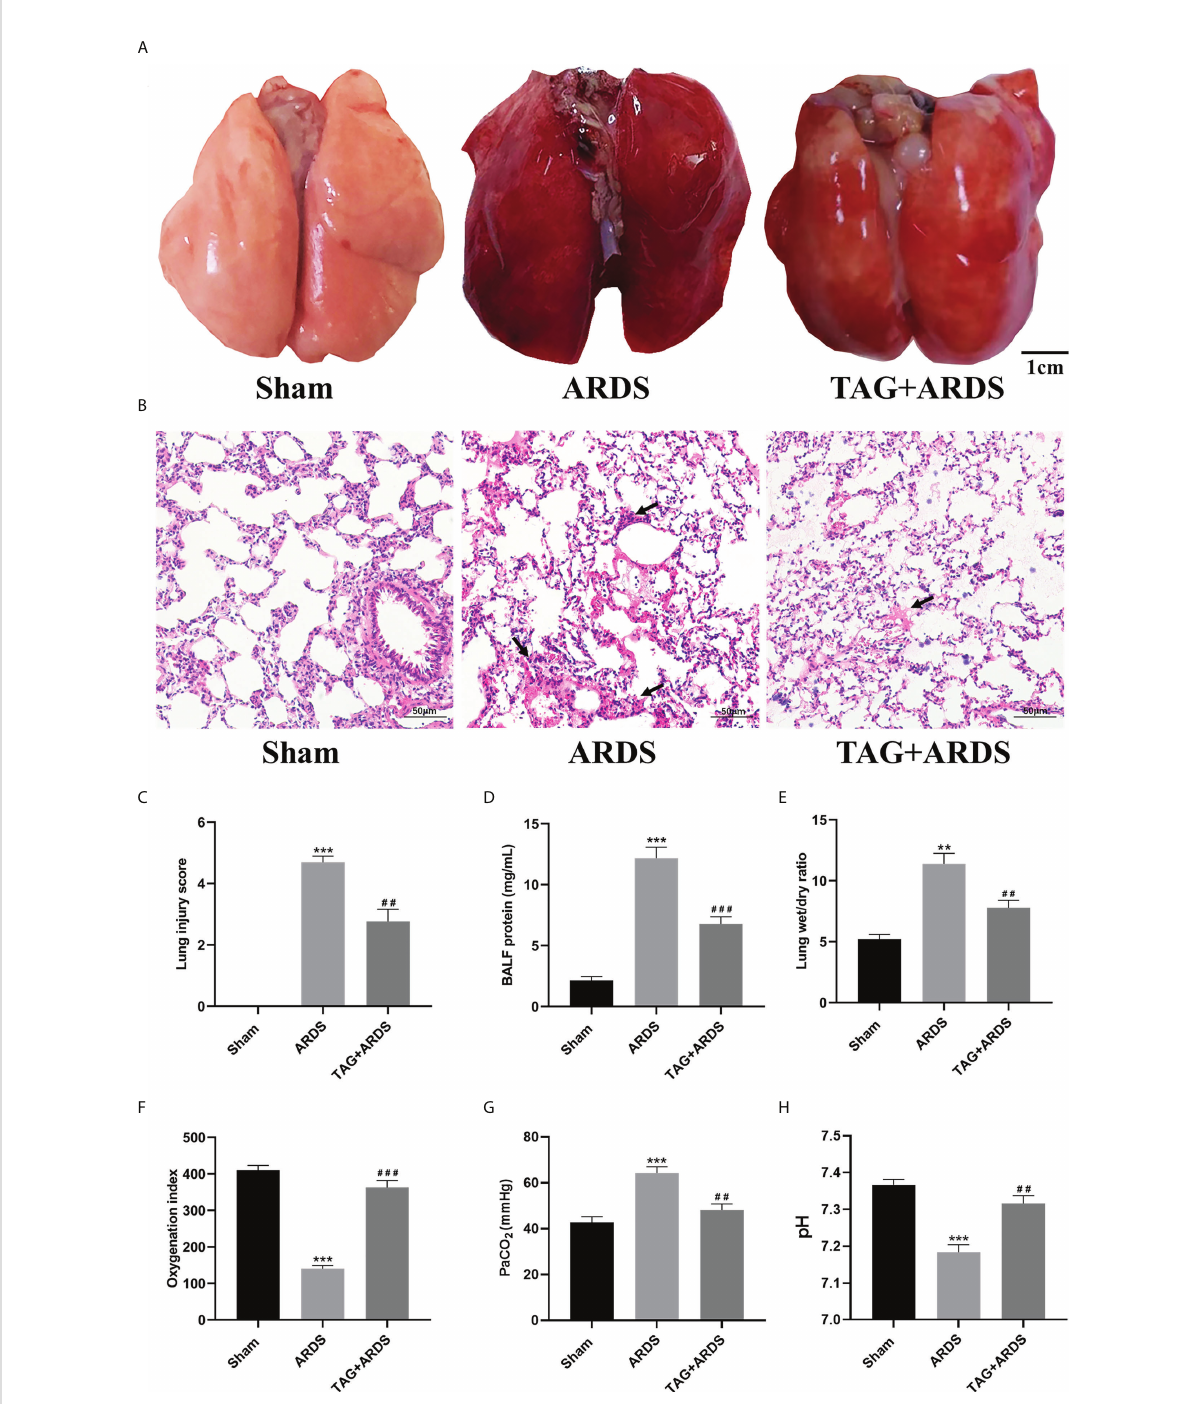
FIGURE 2 TAG pretreatment protects from OA-induced lung injury in Sprague-Dawley rats. (A) Gross pathological images of lung injury across experimental animal groups (scale bar = 1 cm): Sham, ARDS, and TAG+ ARDS (pretreated with TAG 3 days before ARDS induction). (B, C) Representative histological images of lung and lung injury score in the groups (scale bar = 50 m m). Arrows represent edema and in fl ammatory cell in fi ltration in alveolar cavity. (D) Protein levels in BALF in each group. (E) Wet/Dry weight ratio of the left lung. (F – H) OI, PaCO 2 and pH determined for each group. Data are presented as the mean ± SD. ** p < 0.01, *** p < 0.001, compared with the Sham group; ## p < 0.01, ### p < 0.001, compared with the ARDS group. TAG, D-tagatose; OA, oleic acid; ARDS, acute respiratory distress syndrome; BALF, bronchoalveolar lavage fl uid; OI, Oxygenation